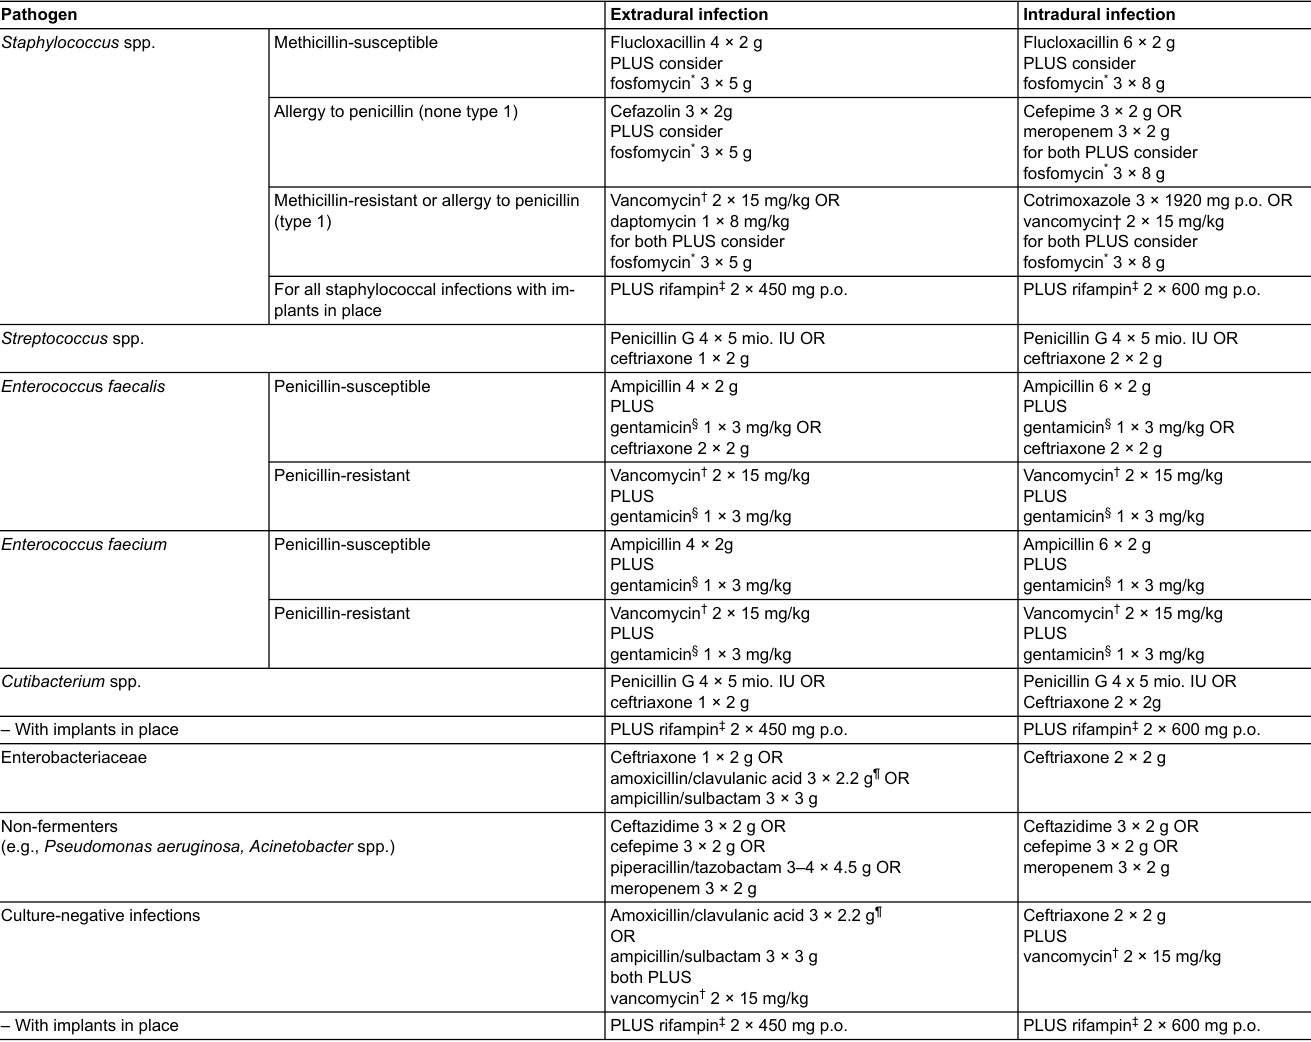
Table 3: Targeted intravenous treatment for intra- and extradural infections (patient’s renal function and body weight must be taken into account). Rifampin treatment is indicated only if an implant is involved. Pathogen Extradural infection Staphylococcus